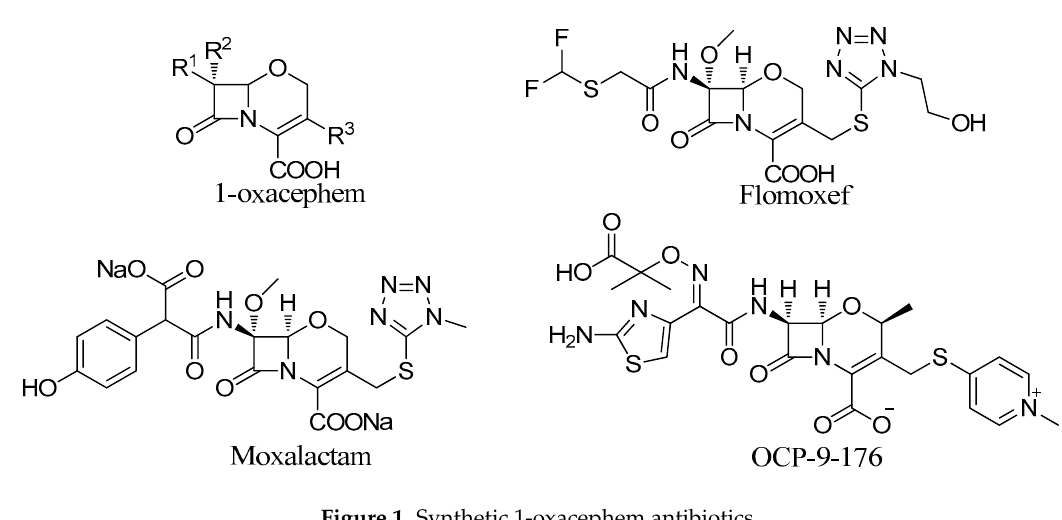
Figure 1. Synthetic 1-oxacephem antibiotics.